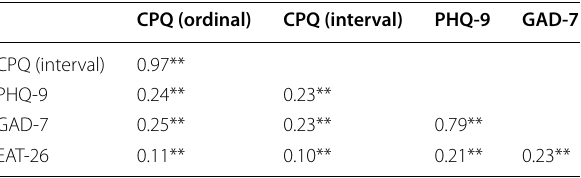
Table 5 Spearman correlations between CPQ (ordinal and interval) and the study variables ( n =